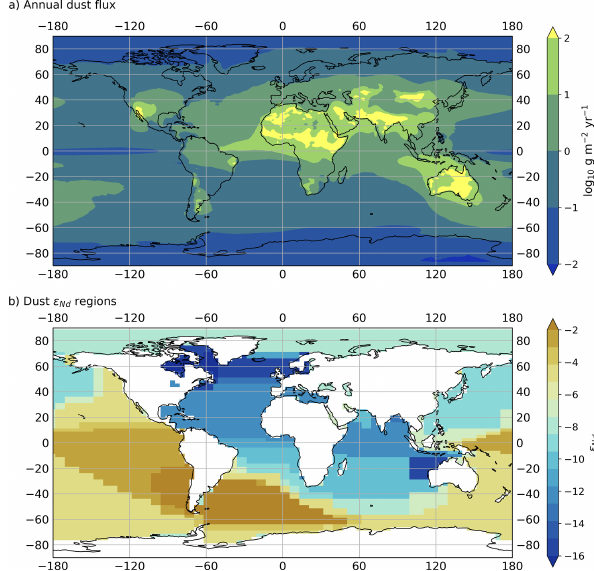
Figure 4. (a) Annual dust deposition taken from the pre-industrial annual mean dust deposition simulated by HadGEM2-A GCM (Hopcroft et al., 2015). (b) The ε Nd signal from dust deposition fol- lowing Tachikawa et al. (2003) and updated with information from Mahowald et al. (2006) and Blanchet